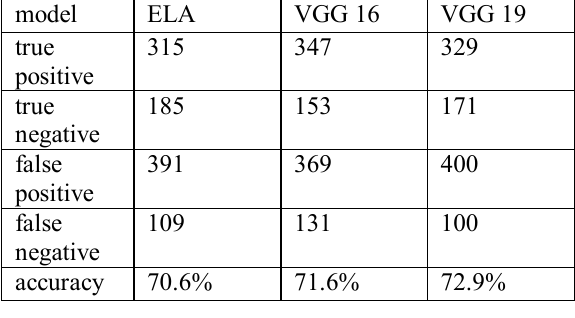
Figure 2 . VGG16 Training Curve